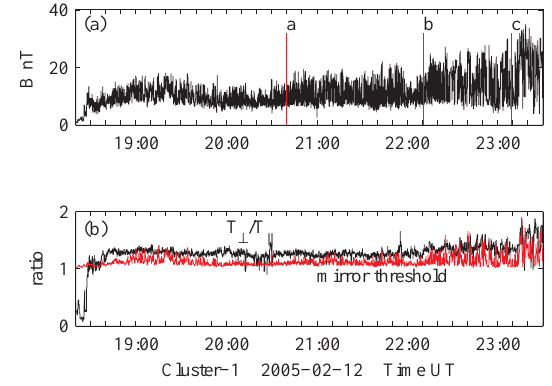
Fig. 2. (a) Perpendicular ion pressure (black line) as measured by Cluster CIS (HIA) experiment in a region of mirror structures. Su- perposed is fit (red line) with expression (4), which yields γ =1.45, κ =0.14. (b) Similar fit for the parallel pressure gives a p 0 =0.8, γ a = − 0.62 and κ a = − 0.24. The correlation coefficient between model and observations for the perpendicular pressure is 0.90 and for the parallel pressure